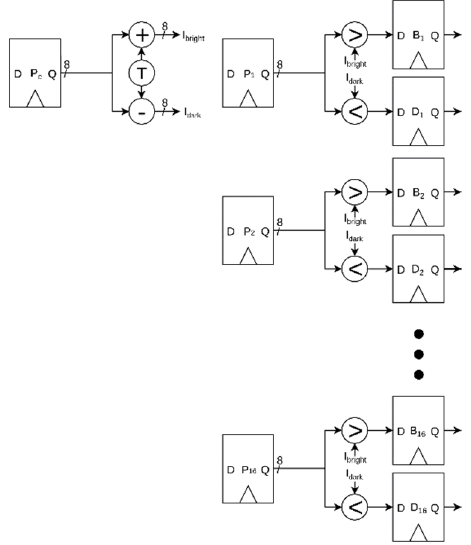
Figure 8. Parallel access and comparison for fast feature detector. P c is the center pixel. P n registers are the ring of pixels. B n registers indicate if the pixel is brighter than the center plus the threshold. D n registers indicate if the pixel is darker than the center minus the threshold.